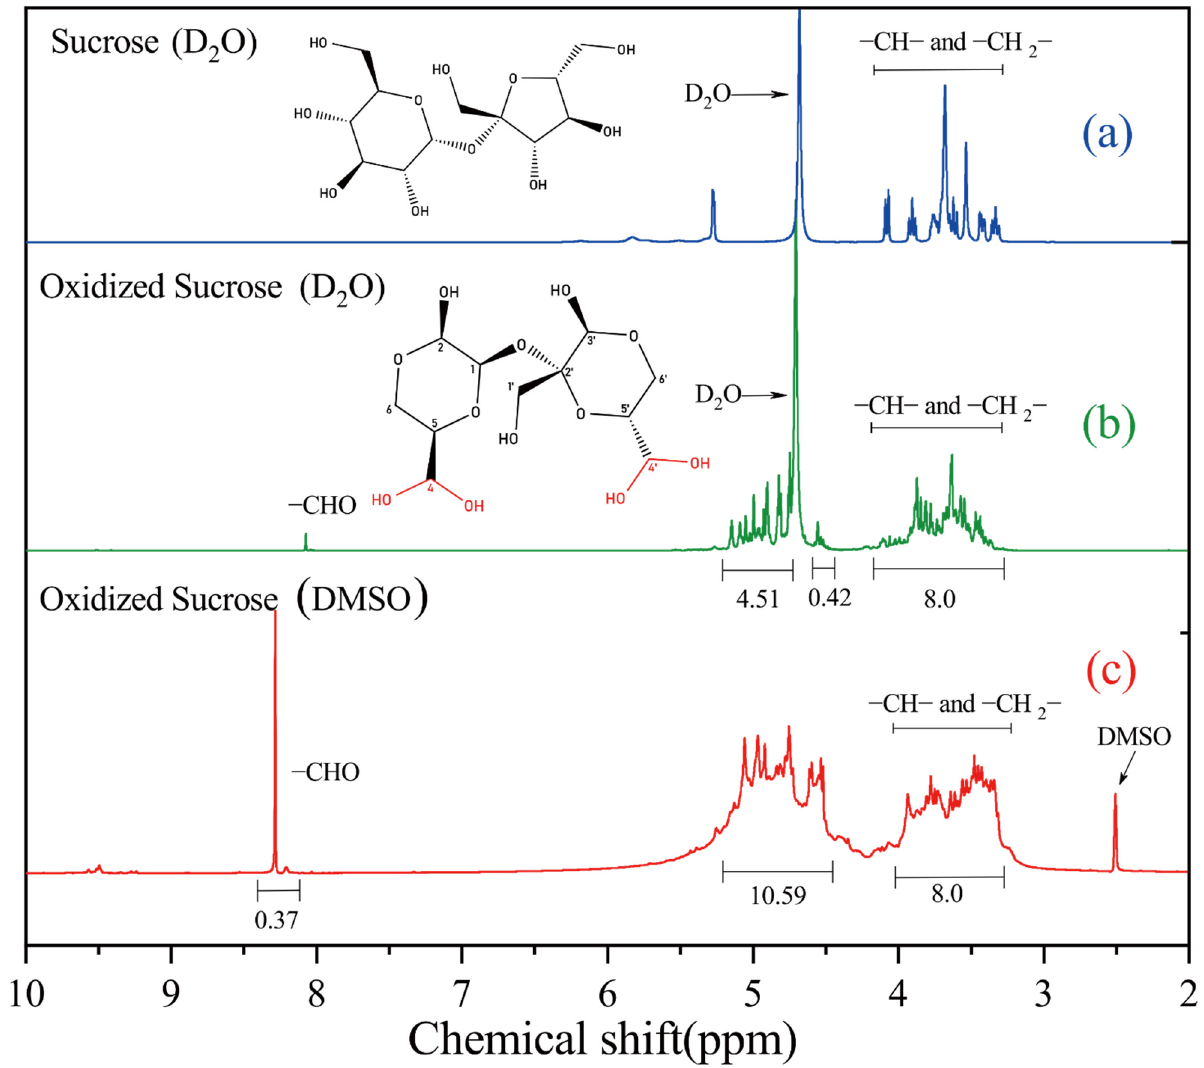
Figure 8. 1 H-NMR spectra of sucrose (D 2 O) ( a ), oxidized sucrose (D 2 O) ( b ) and oxidized sucrose (DMSO) ( c